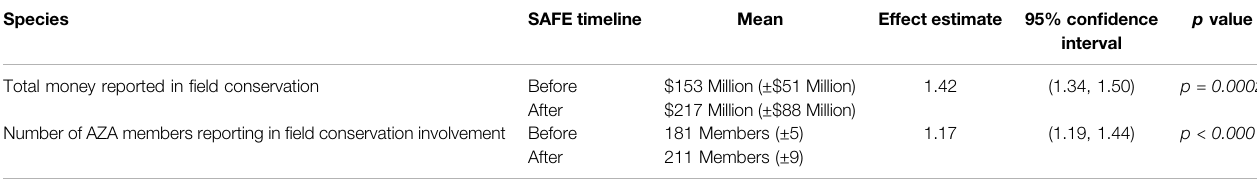
P-values are italicized because they are signi fi cant.